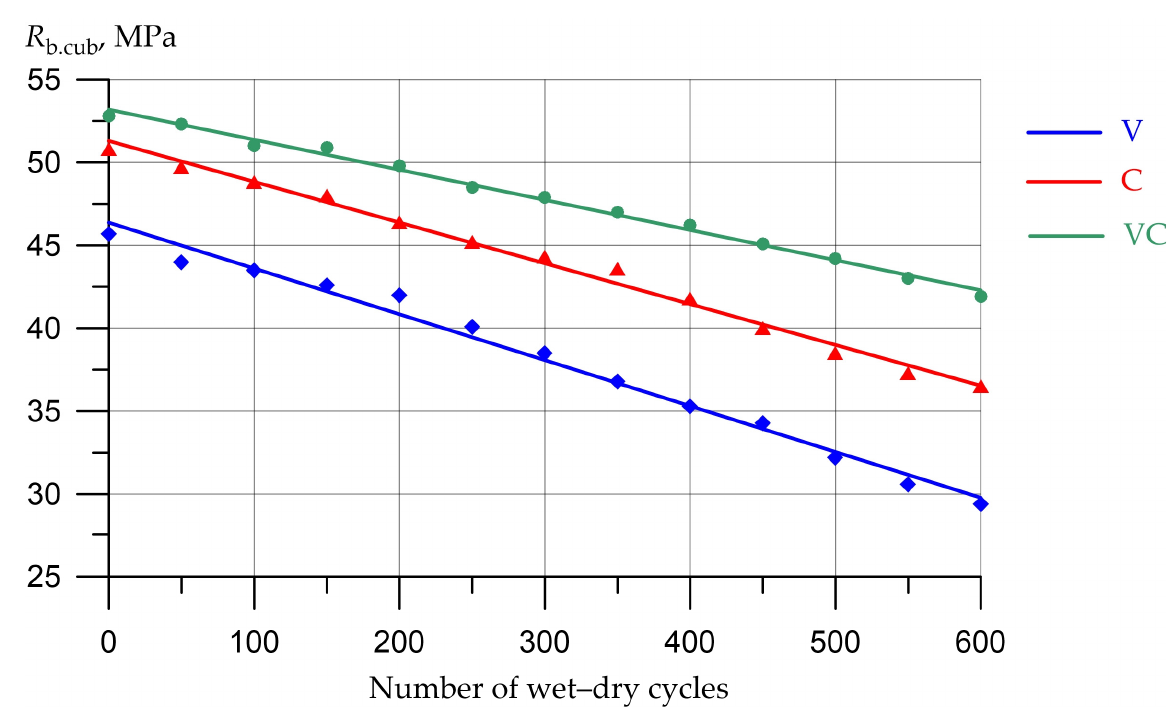
Figure 8. Dependence of the change in the cubic compressive strength of vibrated, centrifuged, and vibrocentrifuged concretes on the number of moistening and drying cycles at pH 5.